Question: Write a single sentence explaining what this figure depicts.
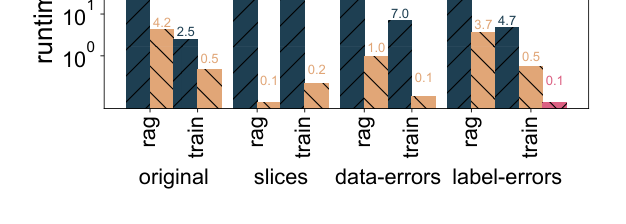
Answer: Benefits of our proposed optimisations for incre- mentally updating the pipelines. The runtime (shown on a log scale) is less than one second in all but one scenarios.